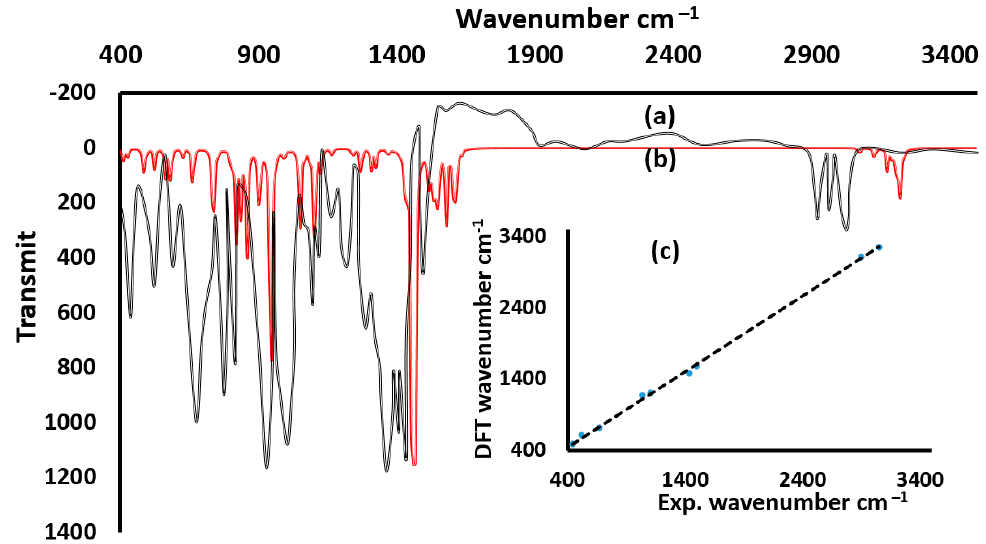
Figure 2. FTIR of cis -Cu(II) complex: experimental ( a ), DFT ( b ) and graphical correlation ( c ). The experimental and time-dependent TD-DFT electronic absorption spectra of the synthesized copper complex was acquired in a spectral range of 200–800 nm. A solution of the complex in methanol displayed two bands in the UV area at λ max = 260 nm and 315 nm (resulting from π - π * electron transfer) and a single band at λ max = 360 nm, which could be attributed to the n- π * electron transfer. Furthermore, a broad band possessing λ max = 515 nm verified in the visible area can be ascribed to the ligand-to-metal charge transfer as seen in Figure 3a. The simulated electronic spectrum was accomplished using a TD-SCF/DFT/CAM-B3LYP method and 6–31G as basis set in methanol (Figure 3b) [31,32]. A wide band appeared at λ max = 330 nm with three electron transition lines at 262 nm, 330 nm, and 375 nm, almost covering the three experimental absorptions. A very broad band was estimated at λ max = 560 nm with ∆ λ = 45 nm of bathochromic shift compared to the same experimental band.